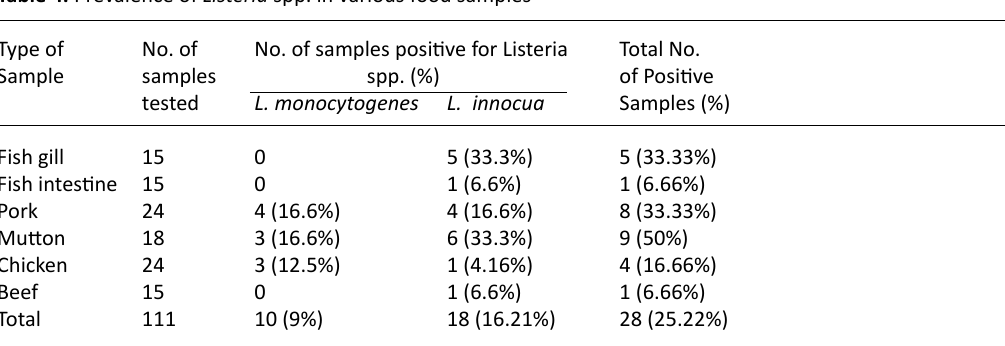
Table 4. Prevalence of Listeria spp. in various food samples Type of No. of No. of samples positive for Listeria Total No. Sample samples spp. (%) of Positive tested L. monocytogenes L. innocua